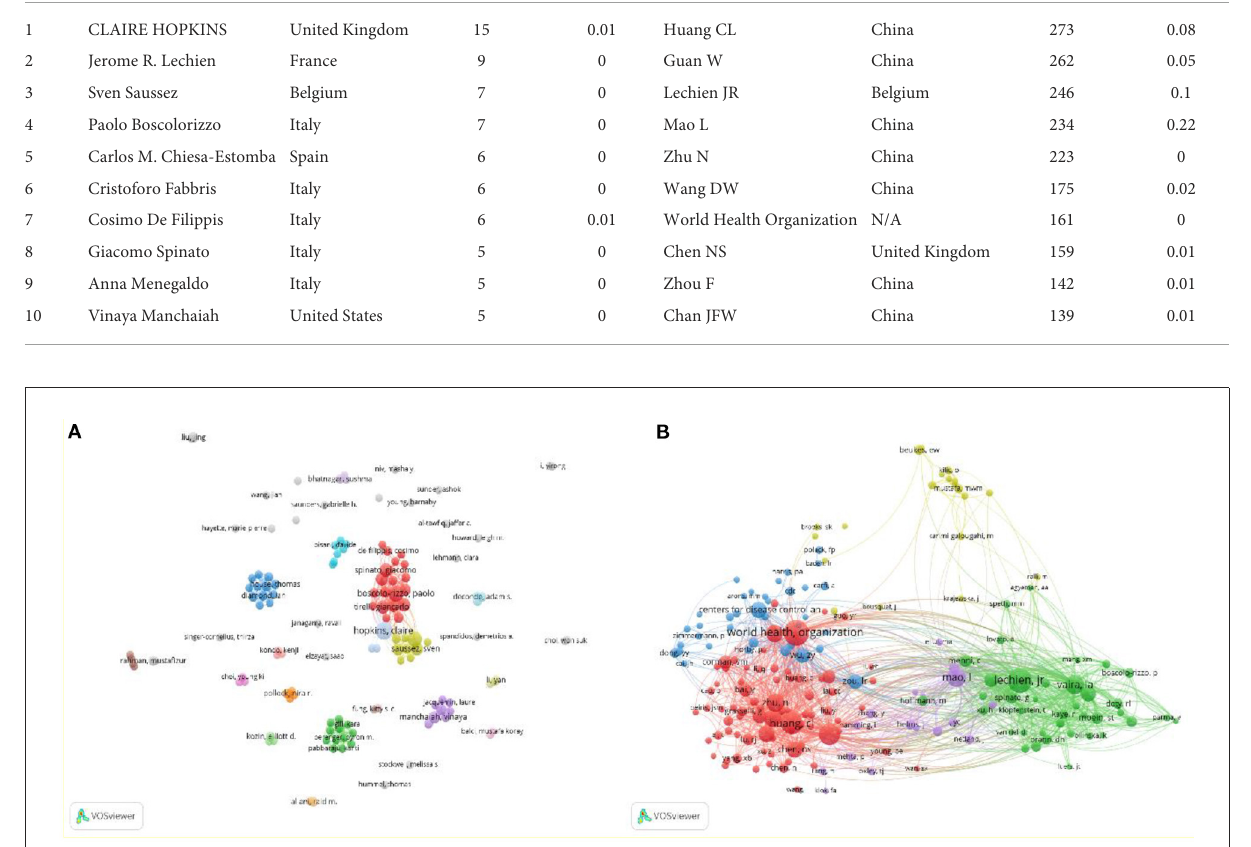
author network (Figure 4B). There were scattered